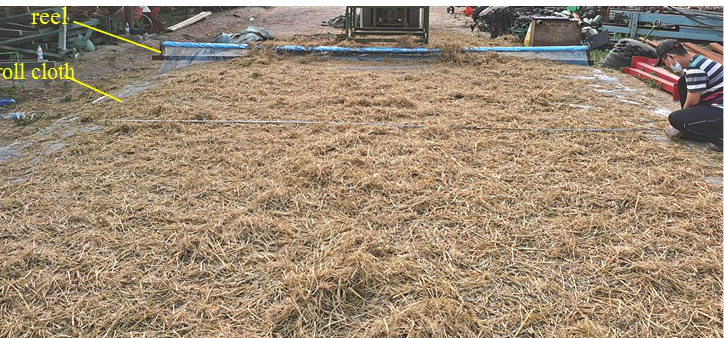
Figure 20. Test effect diagram.